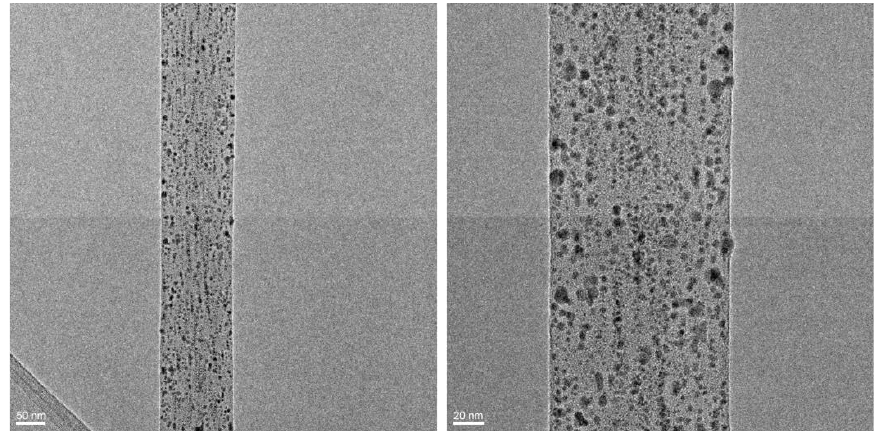
Figure 8. TEM images of PLA/PEO (9:1) — AgNPs fibers (4.0 w% Ag).